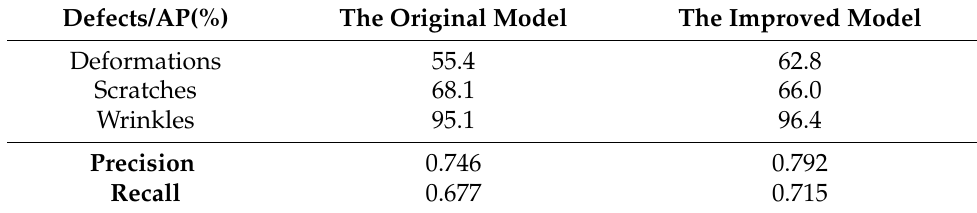
Table 4. Results before and after network